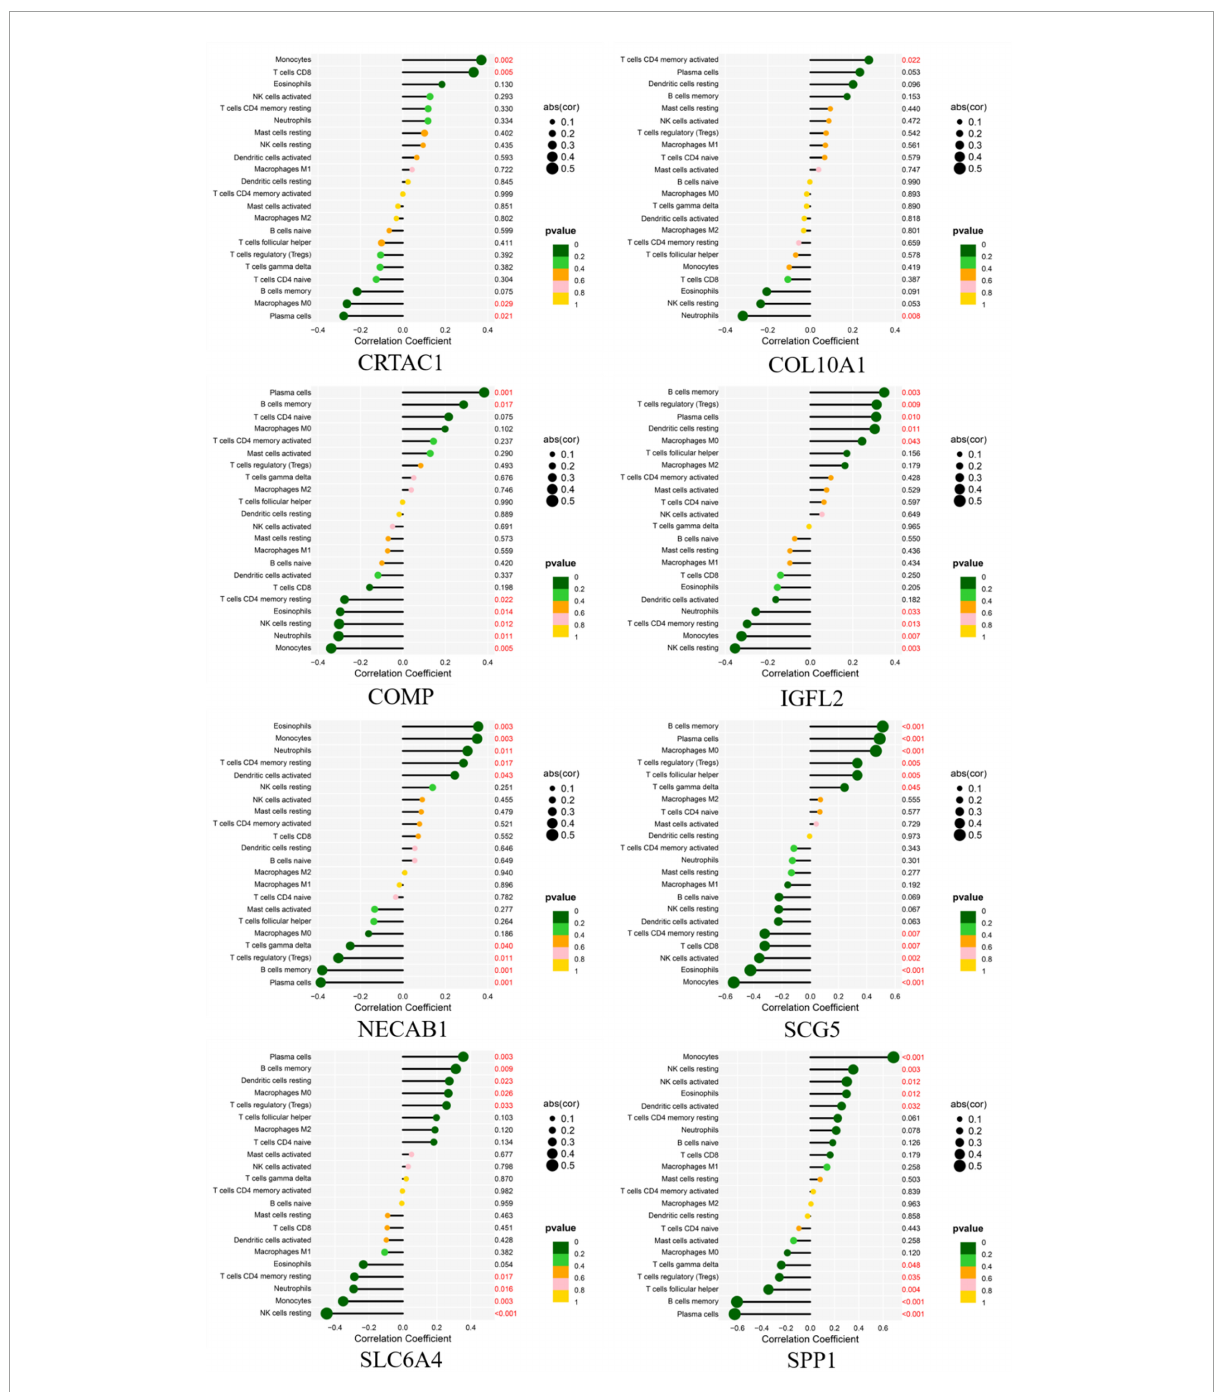
FIGURE14 Correlation between diagnostic gene biomarkers and infiltrating immune cells in IPF.